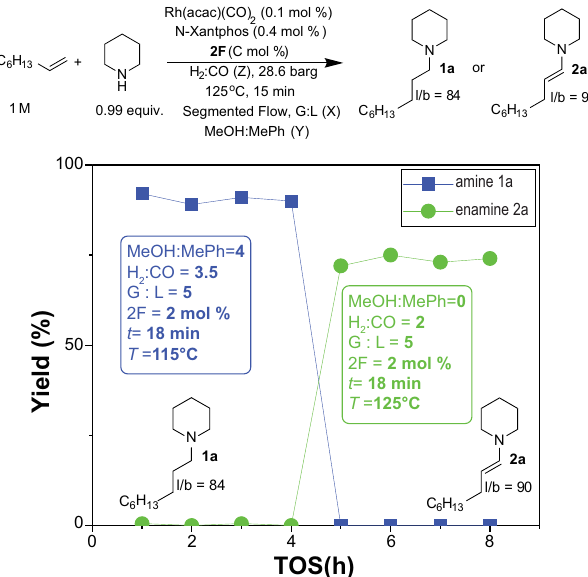
Fig. 6 Online reaction product switching. On-the- fl y selective switching from the amine to enamine formation with Rh/N-Xantphos in the presence of the co-catalyst 2F in the segmented fl ow reactor. G:L is gas to liquid volumetric feed ratio, t : residence time.